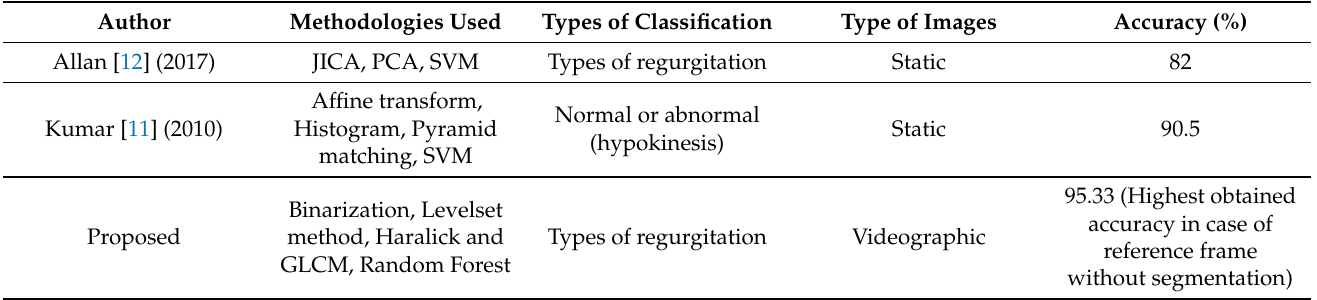
Table 8. Comparison table for all the methodologies in the classification of heart abnormalities.